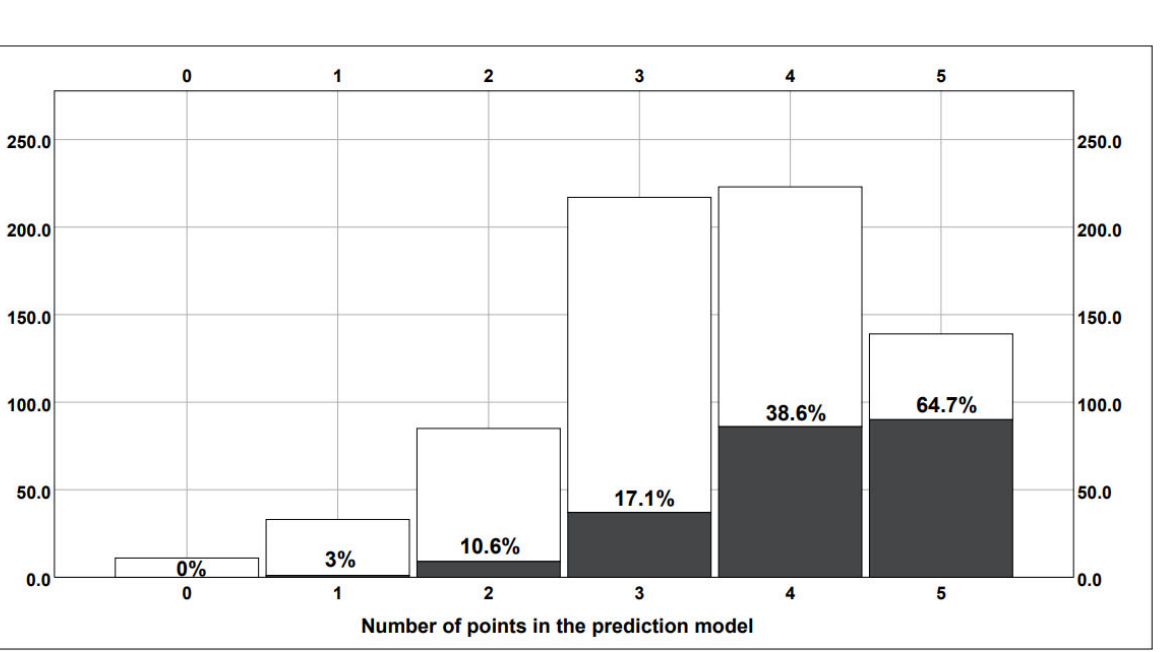
Table 3. Components and weights of parameters in the prediction model for decompressive craniectomy.